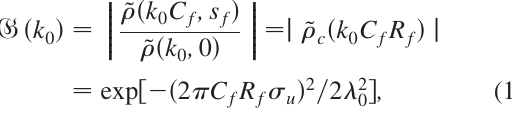
Þ computed with analytical formula in [12] (curves) and numerical gain from our MCP solver (red squares 0